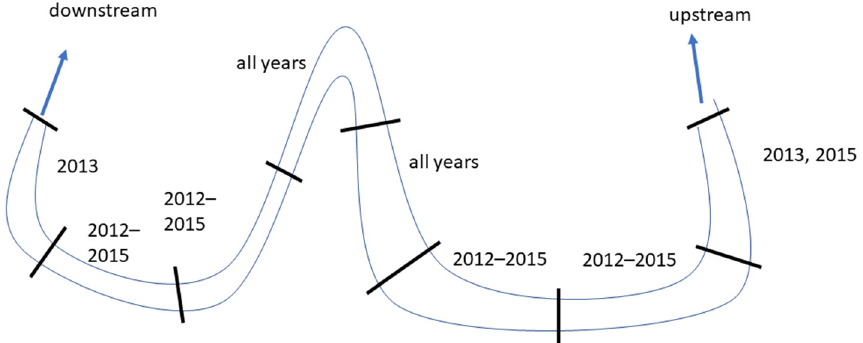
Figure 3. Stylized representation of the stream with sampling segments indicated by solid black lines. Each segment was 100 m in length and the width of the stream varied from two to five meters. Years that each segment was sampled are listed adjacent to the segment. The two segments in the middle labeled as “all years” represent the two original 100 m segments sampled first in 2011 and all years thereafter for the duration of the study. Additional segments were included in the two years with intermittent flow because some parts of all segments were dry.